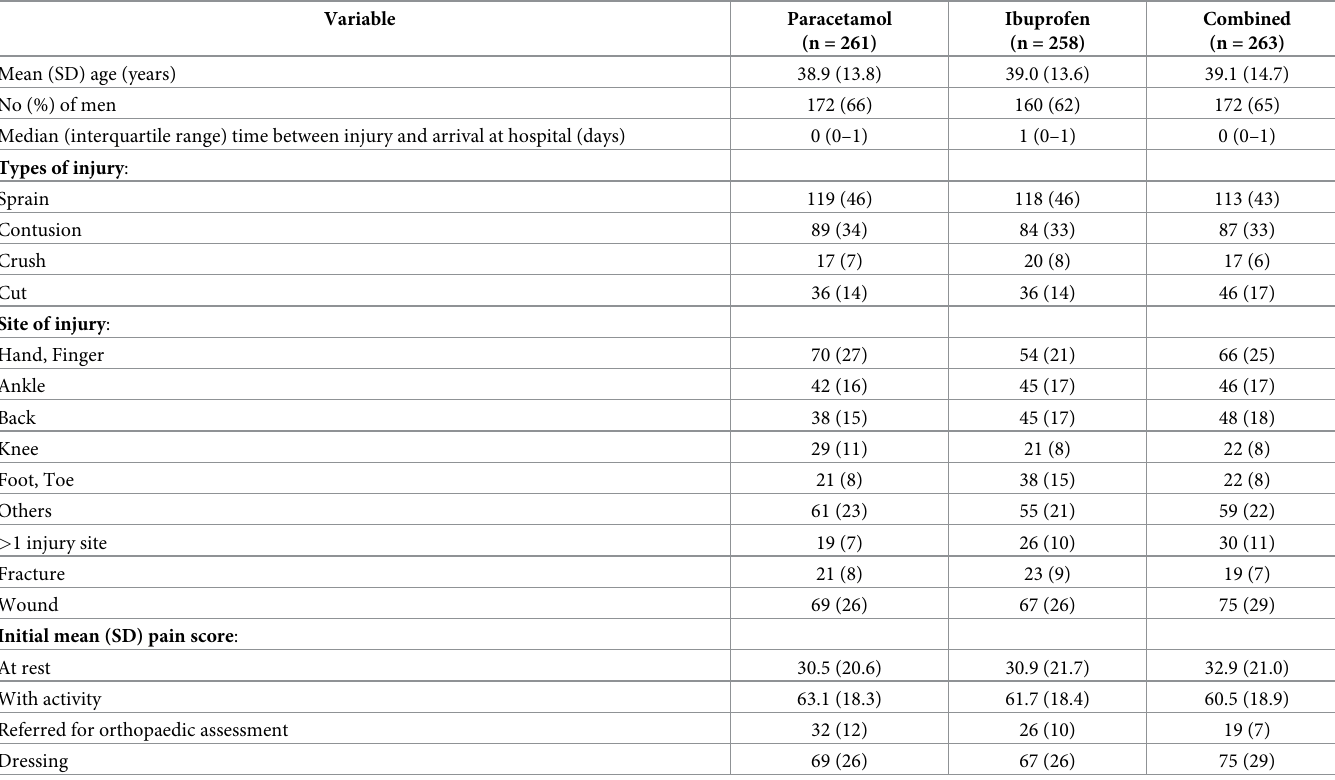
Table 1. Participants’ characteristics (n = 782). Values are percentages of participants unless stated